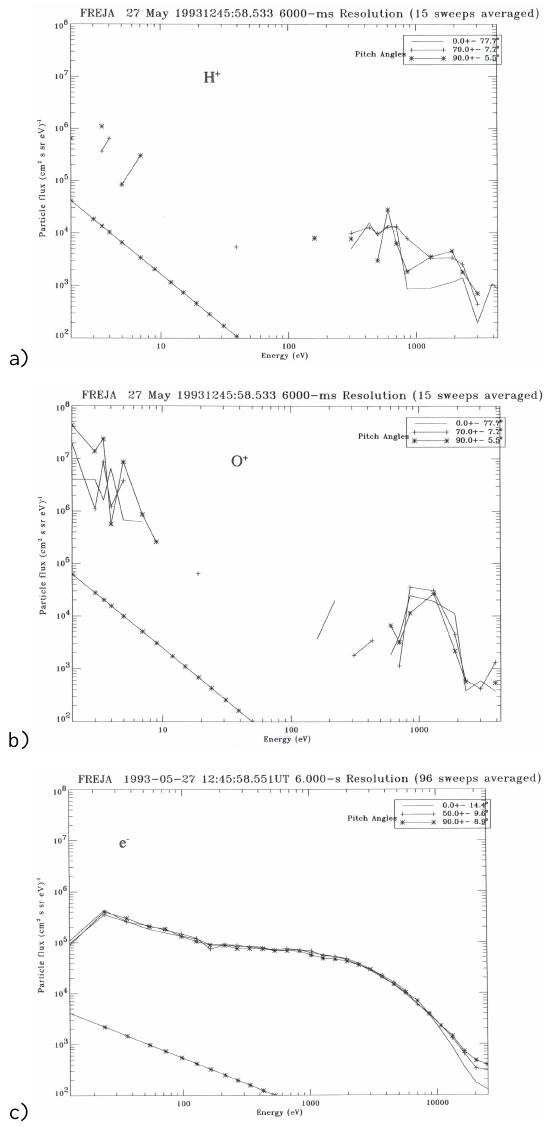
Fig. 8. Detailed energy spectra measured in orbit 3082 of precipi- tated H + ions (a) and O + ions (b) and of the precipitated electrons (c) . Straight lines show 1-count